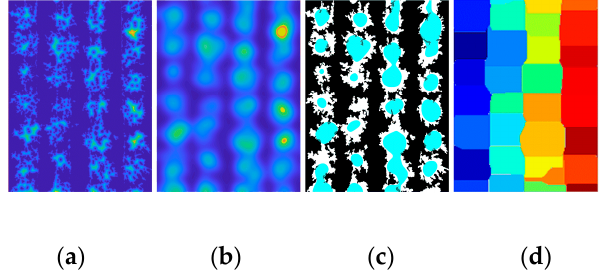
Figure 12. The process of improved Watershed steps . ( a ) Distance transform; ( b ) image blur; ( c ) extremum; and ( d ) color local extremum; and ( d ) color marker.